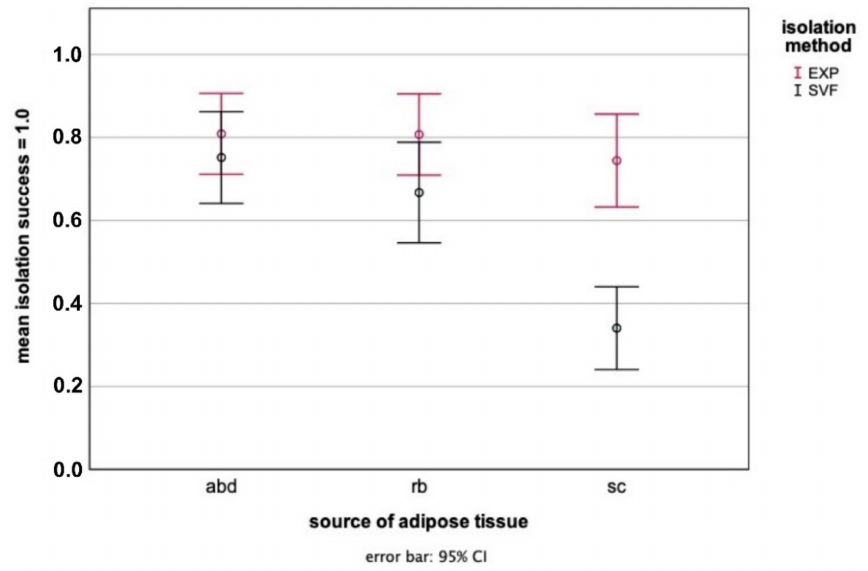
Figure 2. Isolation success of adipose tissue-derived stem/stromal cells (ASCs) harvested by ex- plant culture (ASCs- EXP , red) and collagenase digestion (ASCs- SVF , black) from abdominal (abd), retrobulbar (rb), and subcutaneous (sc) adipose tissue based on the isolation success